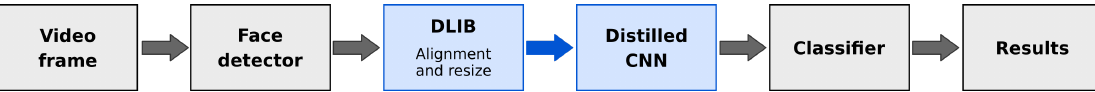
Figure 4. Signal chain of the hybrid framework composed by keeping the former face detector and alignment process; our distilled Convolutional Neural Networks (CNNs) block substitutes ‘dlib-resnet-v1’.